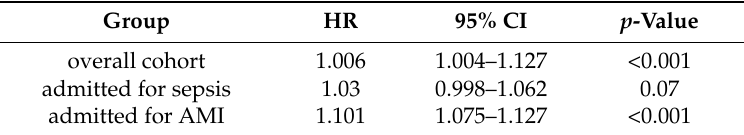
Table 2. In a Cox regression analysis, maximum glucose concentration on the day of admission was associated with mortality in the overall cohort and those patients admitted for